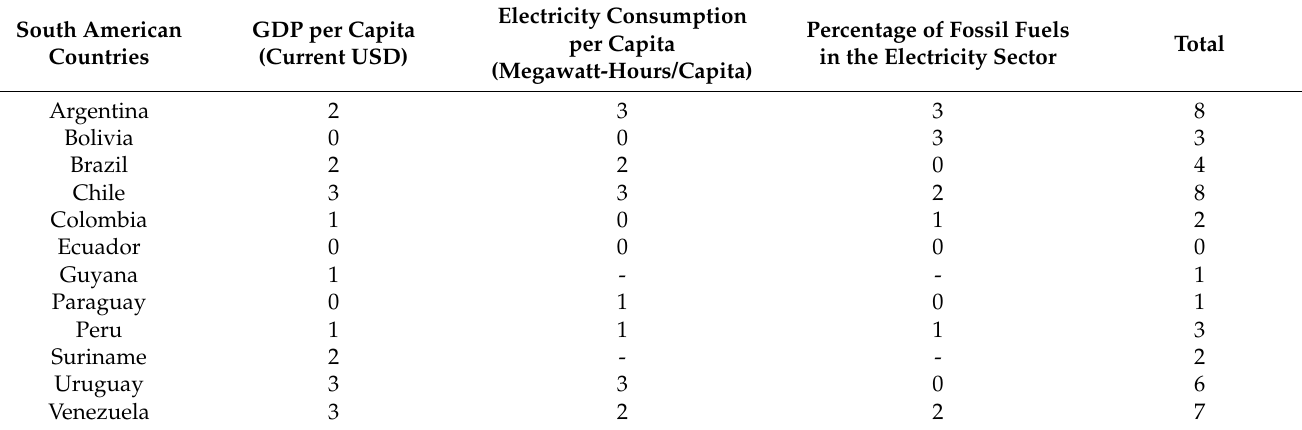
Table 1. Selection of the South American countries based on three indicators